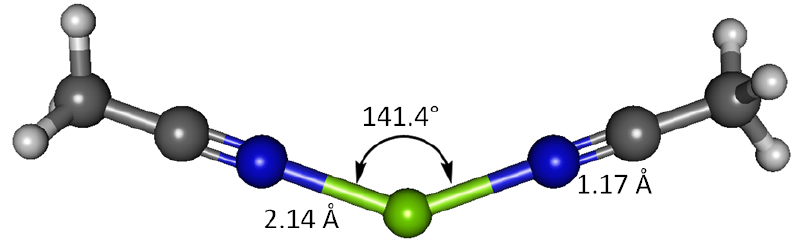
Figure 7. Optimized geometry of Mg(II) complex with two equivalents of acetonitrile.